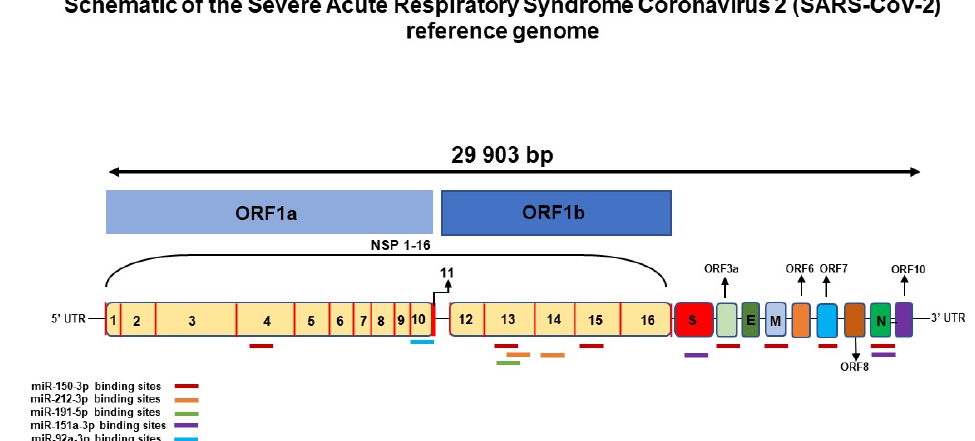
Figure 3. Schematic of the Severe Acute Respiratory Syndrome Coronavirus 2 (SARS-CoV-2) reference genome (NC_045512.2). Computational identification of predicted miRNA response elements (MREs) in the SARS-CoV-2 reference genome. Colored bars represent binding sites for miRNAs in the virus genome.